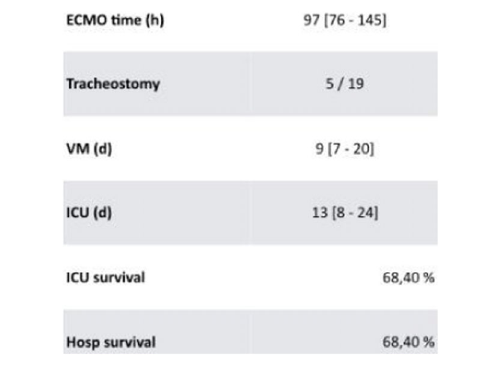
Table 4 (abstract 000914).